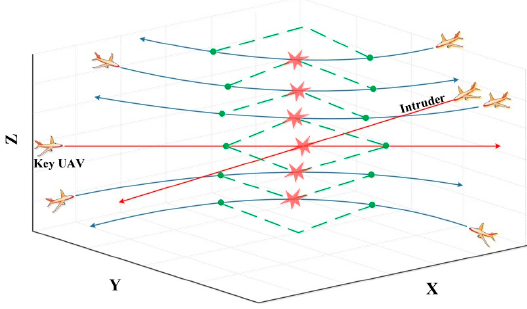
Figure 3. Conceptual graph for sense selection.